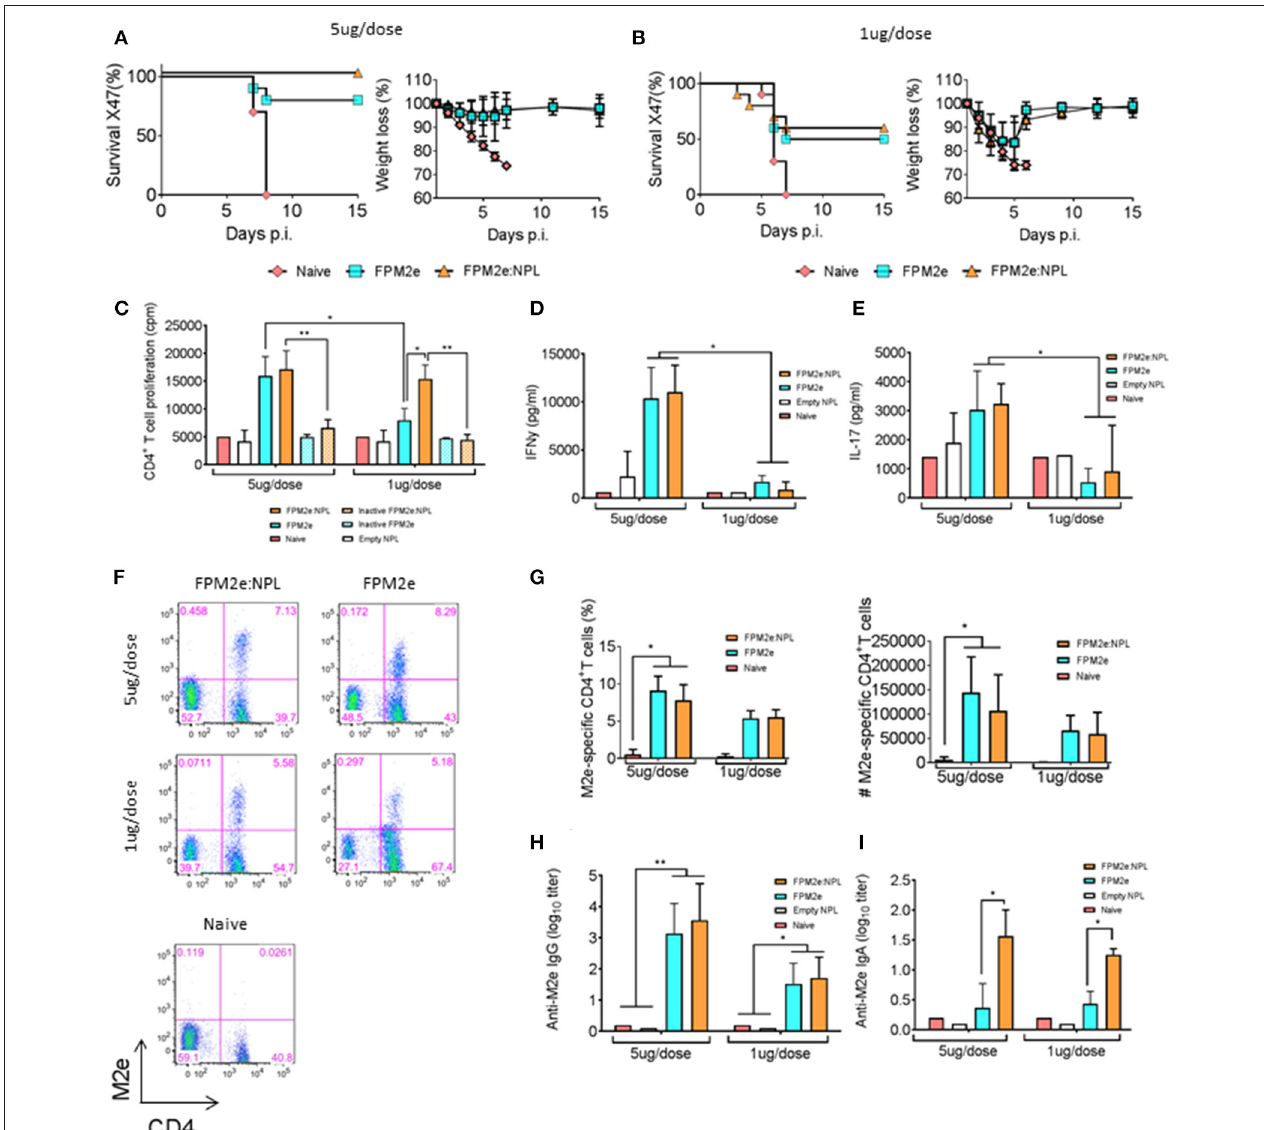
FIGURE 2 | Enhanced immunogenicity of the combined NPL vaccine vector. (A,B) Survival and weight loss were monitored in influenza virus challenged Balb/c mice following three i.n immunizations with 5 µ g (A) or 1 µ g (B) of FPM2e or FPM2e:NPL. The percent of surviving mice (left panel) and body weight loss (right panel) following a challenge infection with 4 × LD50 of the mouse adapted X47 virus strain are plotted. (C) Recall responses to M2e-peptide in primed CD4 + T cells following i.n immunizations with 5 or 1 µ g of enzymatically active or inactive mutant FPM2e or FPM2e:NPL or empty NPL w/o FPM2e, as indicated. Mean proliferation in isolated splenocytes to M2e peptide is given as mean c.p.m ± S.E.M. (D,E) The production of IFN- γ (D) or IL-17A (E) to recall stimulation with M2e-peptide of the primed CD4 + T cells (as in C ) is given in pg/ml ± SD. (F,G) Representative FACS plots of M2e-tetramer + CD4 + T cells in the lungs of i.n immunized and challenged mice as indicated (F) . The percentage (left panel) and absolute number (right panel) of antigen primed M2e + tetramer CD4 + T cells (G) . (H,I) M2e specific IgG antibodies in serum (H) or IgA antibodies in BAL (I) were measured by ELISA in Balb/c mice immunized i.n. with FPM2e, FPM2e:NPL or PBS (naïve), as indicated,